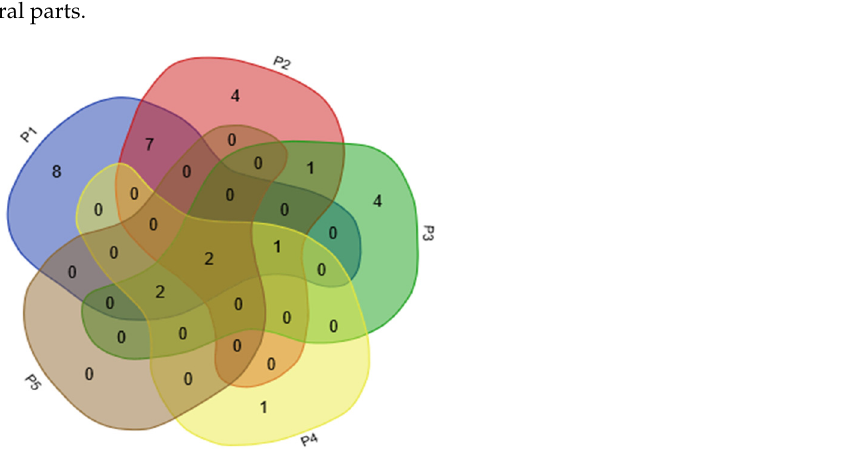
Figure 6. Venn analysis of VOCs identified from five floral organs in L. caudata . P1, stamen; P2, petal; P3, calyx; P4, pistil; P5, pedicel.